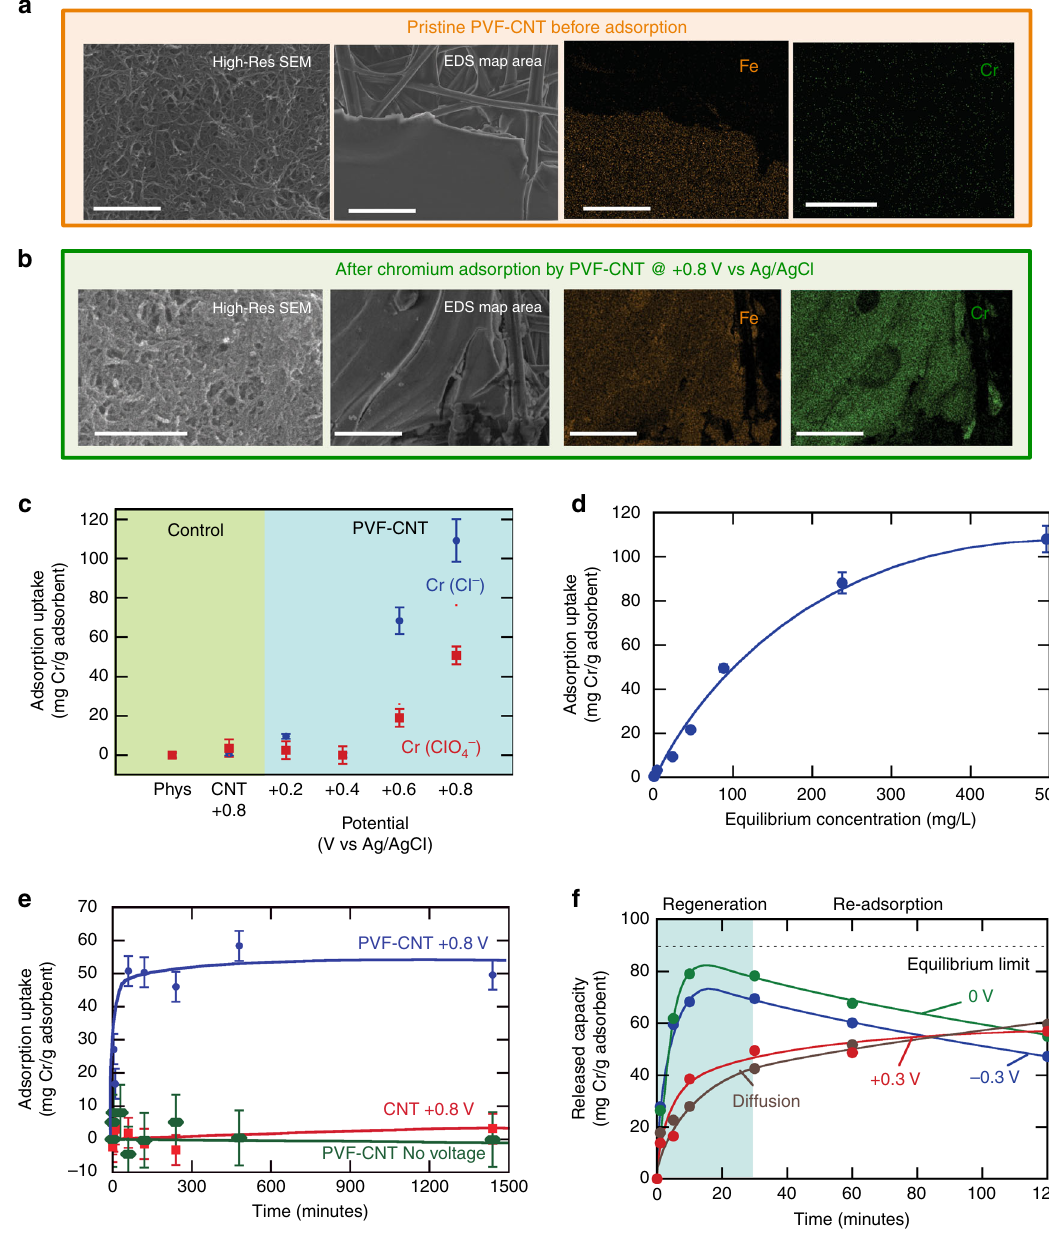
Fig. 1 Electrosorption of chromium oxyanions by PVF-CNT. a Scanning electron microscopy (SEM) images of the PVF-CNT electrodes before the adsorption of chromium, and EDS mapping of the iron of the metallopolymer, and of adsorbed Cr. b SEM micrographs and EDS mapping after chromium adsorption. The area corresponding to the PVF is also saturated with the adsorbed Cr. c Comparison of chromium-uptake capacity of PVF-CNT and CNT electrodes, for 1 mM (NH) 4 Cr 2 O 7 in 20 mM NaClO 4 and in 20 mM NaCl. No Cr adsorption occurs on a PVF-CNT electrode without potential, and a much higher adsorption capacity for PVF-CNT than pristine CNT is observed at + 0.8 V vs. Ag/AgCl potential adsorption. d Equilibrium isotherm for PVF-CNT at + 0.8 V vs. Ag/AgCl adsorption for a range of (NH) 4 Cr 2 O 7 concentrations in 20 mM NaClO 4 . e Adsorption kinetics for Cr at 1 mM (NH) 4 Cr 2 O 7 in 20 mM NaClO 4 . f Effect of discharge potential on regeneration ef fi ciency of the PVF-CNT electrodes, measured by the normalized mass of Cr released (mg Cr/g PVF polymer). Electrodes were charged at + 0.8 V (vs. Ag/AgCl) and discharged at 0, − 0.3, and + 0.3 V into 20 mM NaClO 4 , and dynamic results were compared to a diffusion-controlled case in which the electrode was left in the desorption solution under no applied potential. Scale bar for